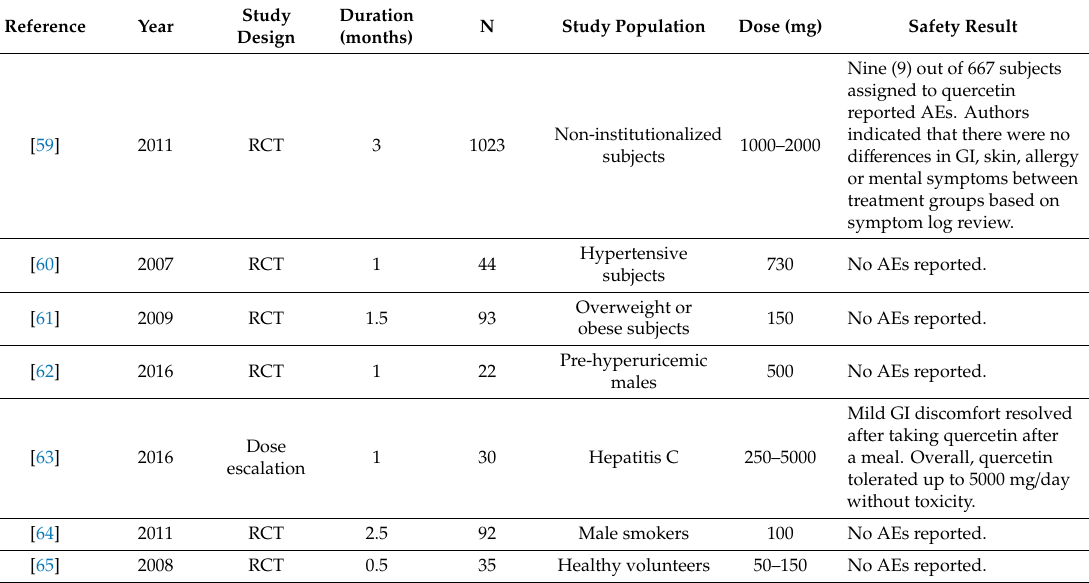
Table 2. Summary of Safety Profile of